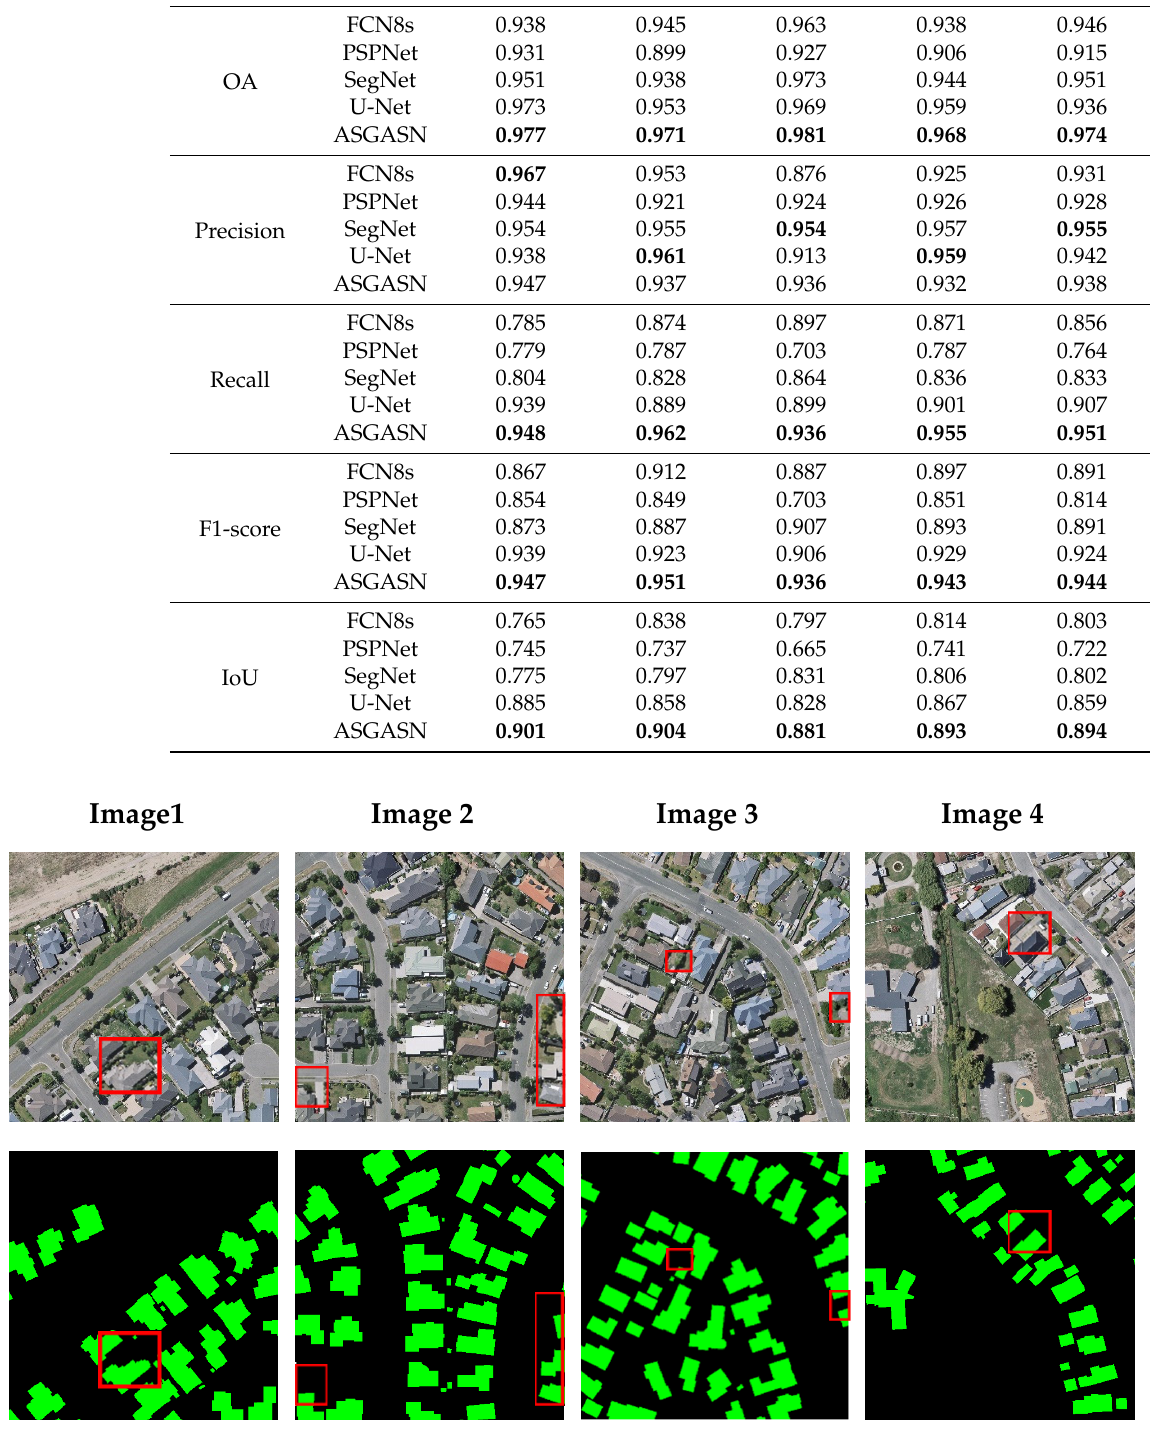
Table 2. Quantitative comparison with the state-of-the-art models on the WHU dataset. The highest value for each metric is marked as bold. Metrics